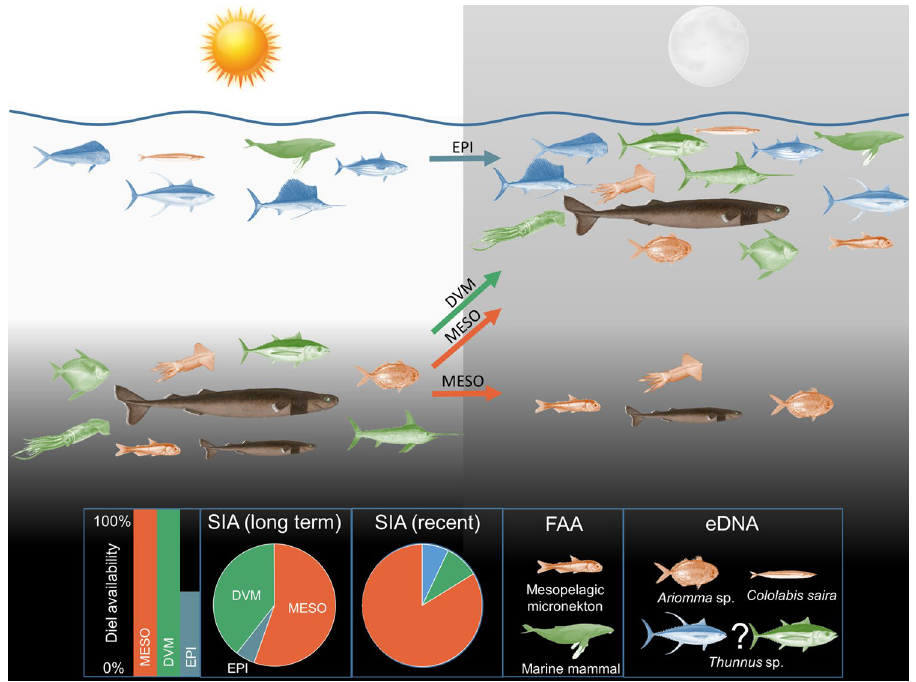
Figure 6. Conceptual figure showing diel shifts in depth distribution of Cookiecutter sharks and different prey groups (DVM, MESO, EPI) as well as relative importance of different prey. The inset shows how the availability of different shark prey groups varies over the course of the diel cycle, as well as information on the diet of Cookiecutter shark revealed by the different chemical tracers. Representative prey of the different prey groups are color coded (MESO: orange, DVM: green, EPI: blue). Note that the question mark by the Thunnus sp. in the eDNA inset reflects our inability to assign those stomach contents to either the EPI or MESO prey